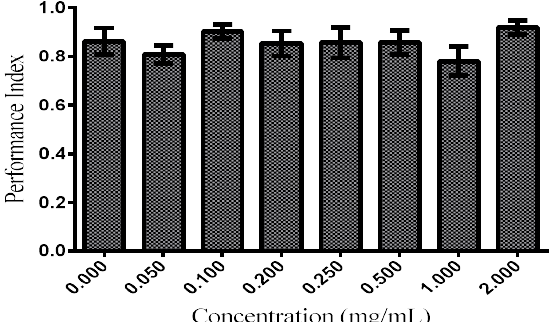
Figure 3. Performance index of the Drosophila melanogaster in the geotaxis negative assays. The values are expressed as means ± S.E.M ( n = 3) as calculated by one-way ANOVA followed by Tukey’s multiple comparisons test with a single pooled variance ( p < 0.05). No significant differences between concentrations.